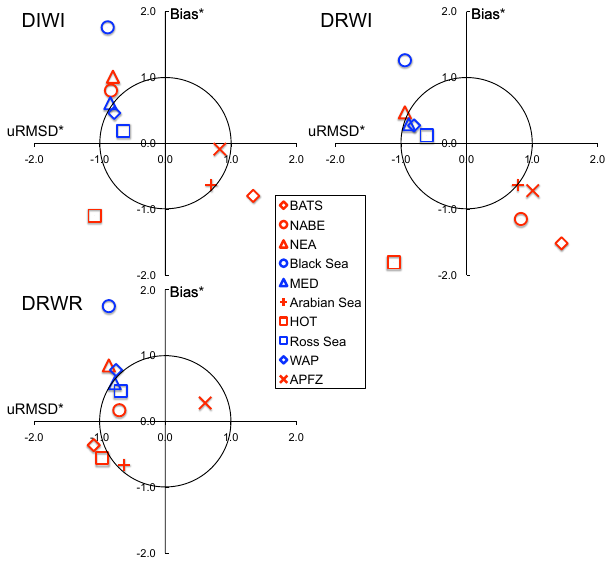
Fig. 4. Target diagrams representing average model skill at each region for DIWIs (11 models), DRWIs (4 models), and DRWRs (6 models). Bias ∗ and uRMSD ∗ are normalized such that Bias and uRMSD are divided by the standard deviation of in situ NPP data ( σ d ) at each region. The solid circle is the normalized standard deviation of the in situ NPP data at each region. Symbols falling within the circle indicate that models estimate NPP more accurately than using the mean of the observed data (Model Efficiency > 0) at each region. Red symbols are the pelagic regions and blue symbols are